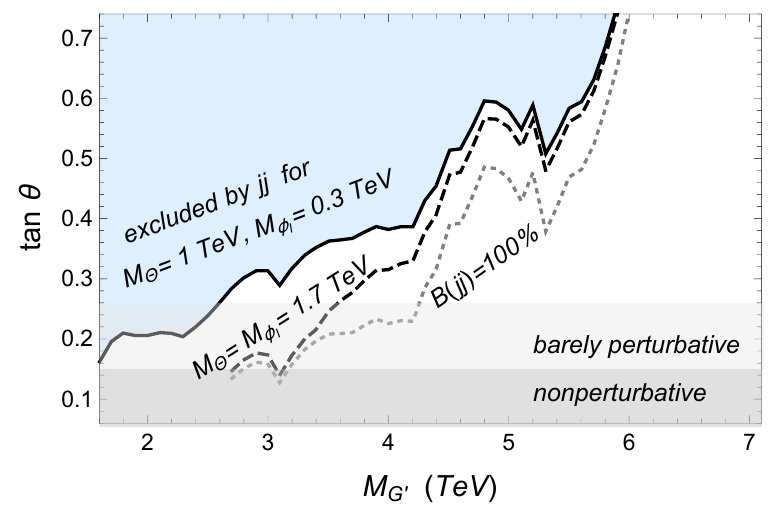
Figure 7 . Excluded regions of the coloron parameter space. Region above solid black line is ruled out, for M (cid:2) = 1 TeV and M (cid:30) = 300 GeV, by jj resonance searches, assuming that pp G 0 jj I ! ! is the only new-physics process contributing to the dijet (cid:12)nal state. Similarly, the region above the dashed line is ruled out for M (cid:2) = M (cid:30) = 1 : 7 TeV. The region above the dotted line is ruled I out when the e(cid:11)ective jj branching fraction is 100% (e.g., scalar masses are above M G = 2 and the 0 boosted t (cid:22) t signal mimics a jj one). In the region labelled \barely perturbative", the expansion parameter for loops that involve the coloron self-coupling is relatively large [3 h 2 = (16 (cid:25) 2 ) between 2 1/3 and 1] so that the tree-level result is expected to get sizable